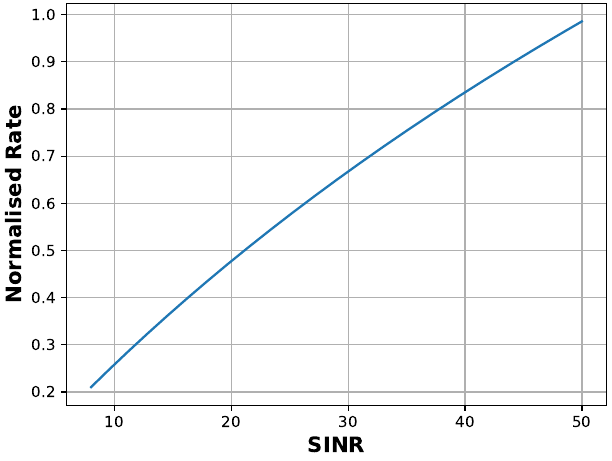
Figure 6. Normalised rate with SINR.